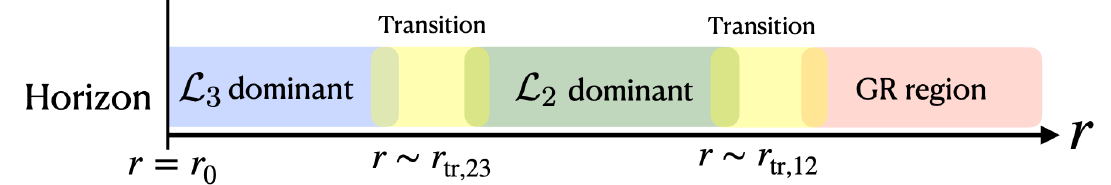
Figure 8 . Three separate regions in the Einstein-Lovelock black hole with L 2 and L 3 corrections for 1 (cid:28) . α 2 (cid:28) α 3 (cid:28) α 2 b b b 2